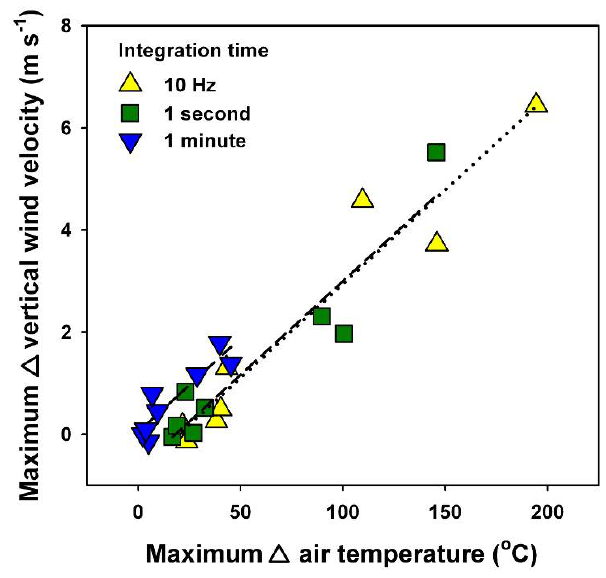
Figure 5. Relationships between maximum ∆ air temperatures and maximum ∆ vertical wind velocities measured at 10 Hz and integrated to 1 s and 1 min intervals during the eight prescribed fires. Data are presented in Tables 4 and A3, and statistics are in Table 5.